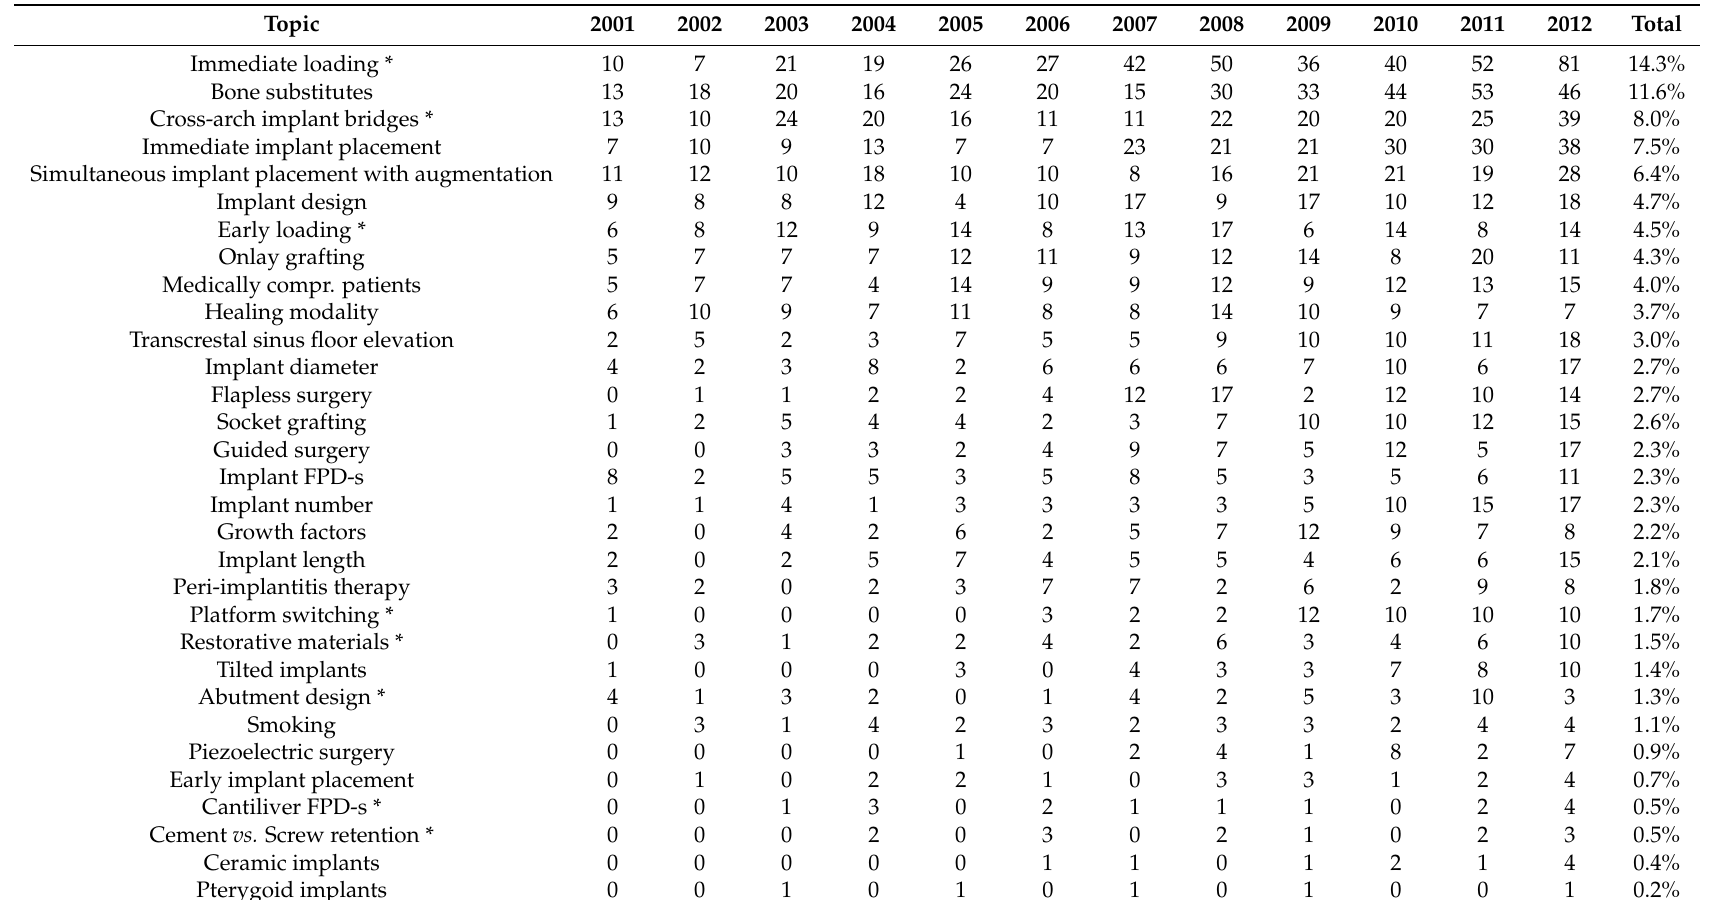
Table 1. Topics sorted by literature coverage. Absolute numbers of publications per year as well as the total percentage of all clinical papers 2001–2012 (* indicates prosthodontic